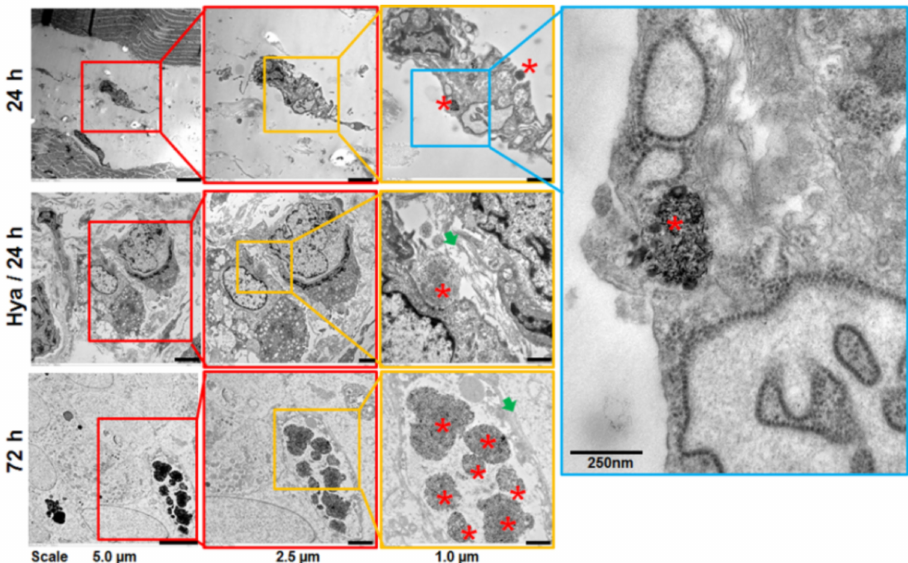
Figure 7. Ultrathin transmission electron micrographs of tumor tissues. The tumor tissue from the 24 h mice group show damaged tumor stroma and many invasive cells infiltrating the muscle. Likewise, tumor tissue from the hyaluronidase- treated Hya/24 h group show many intact tumor cells but a degraded and relaxed stroma with fragmented collagen fibers (green arrows). In contrast, the regrown tumor tissue from the 72 h mice group shows compactly arranged cells and stroma (green arrow). Some of the tumor and stromal cells in all groups show vesicles containing partly intact Dex-MNP (asterisks), which is especially high in the 72 h group.